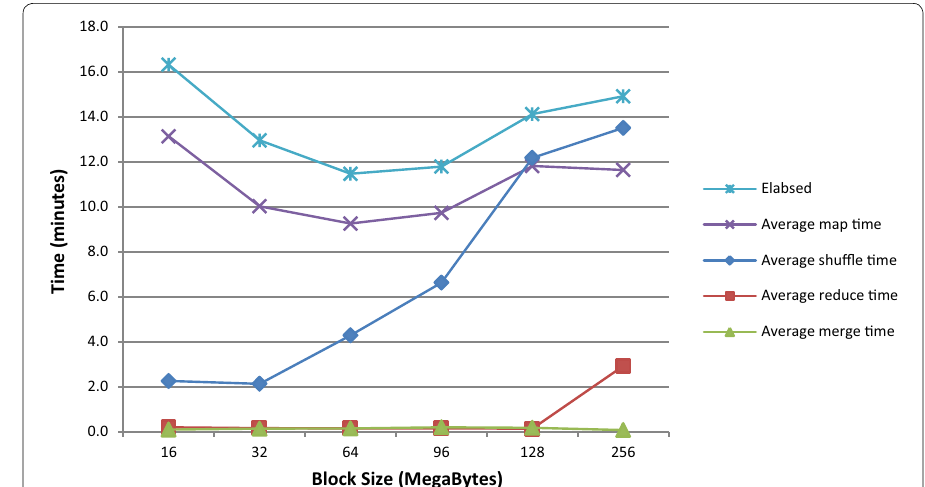
Fig. 24 Clustering 1.9 GB raster image with a 2 node Hadoop cluster